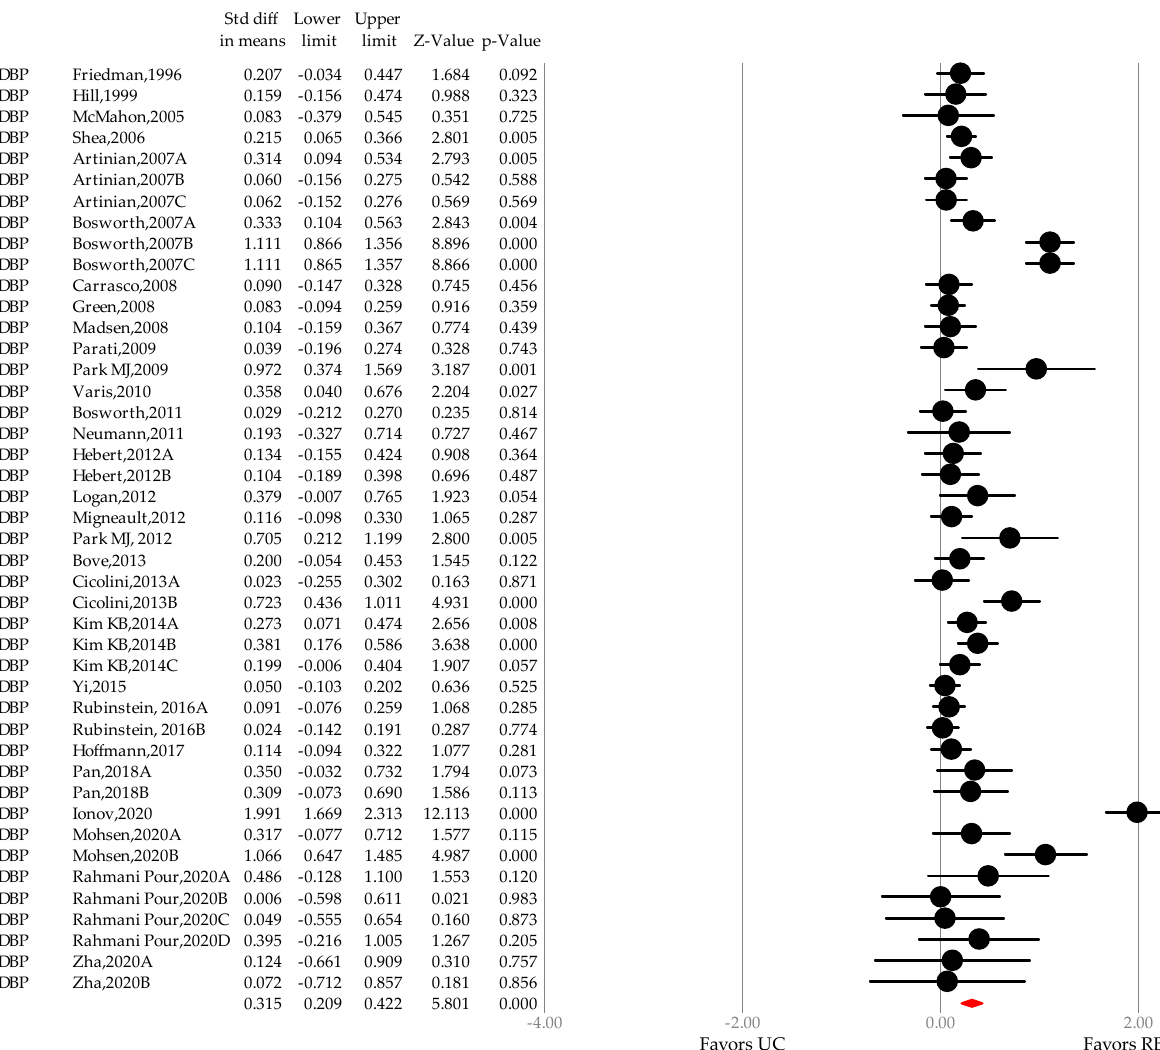
Figure 3. A funnel plot of standardized mean difference in diastolic blood pressure. Note: summary effect size ( ◇ ), sum- mary effect size of imputed studies ( ◆ ), individual study ( ○